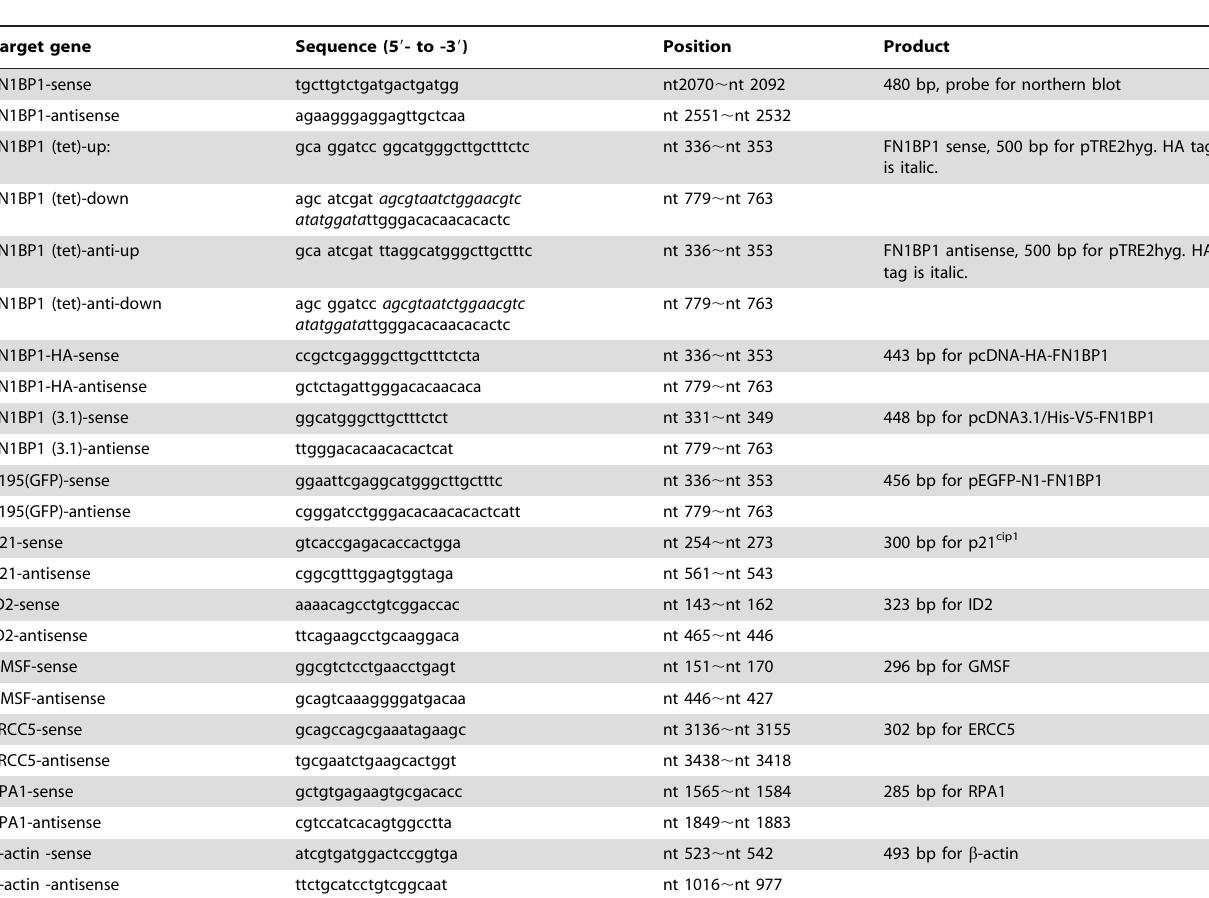
Table 1. Primers used in this